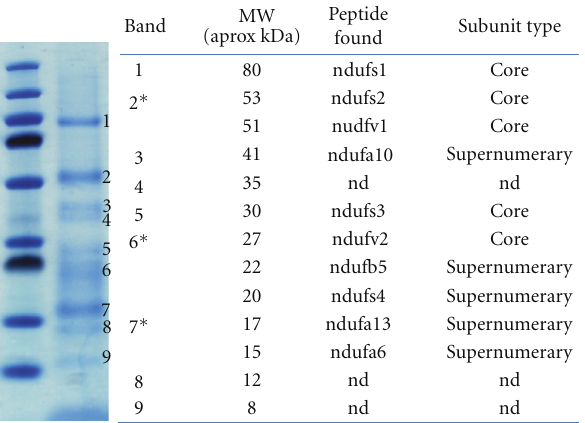
Figure 3: Electrophoresis of mitochondrial proteins isolated from the mouse brain following Complex I immunoprecipitation and counterstained by Coomassie blue are shown in the second lane. The first lane has the molecular weight standards. The table indicates the identity of bands submitted for mass spectroscopy to be subunits of Complex I. ( ∗ )—subunits identified within the same excised band. (nd)—not